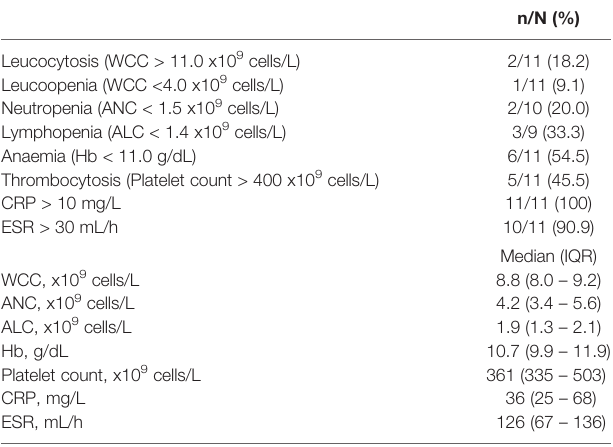
TABLE 2 | Laboratory